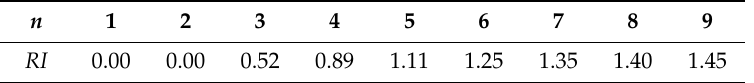
Table 2. Average random consistency index ( RI )